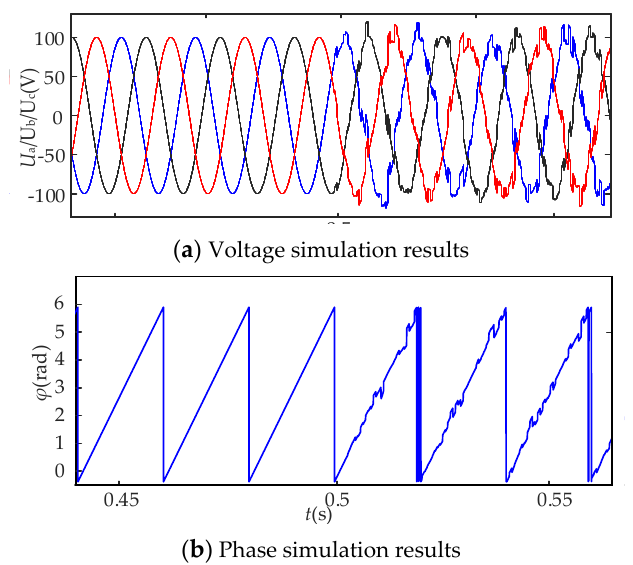
Figure 11. Three-phase voltage and phase simulation waveform captured by the conventional OPD.